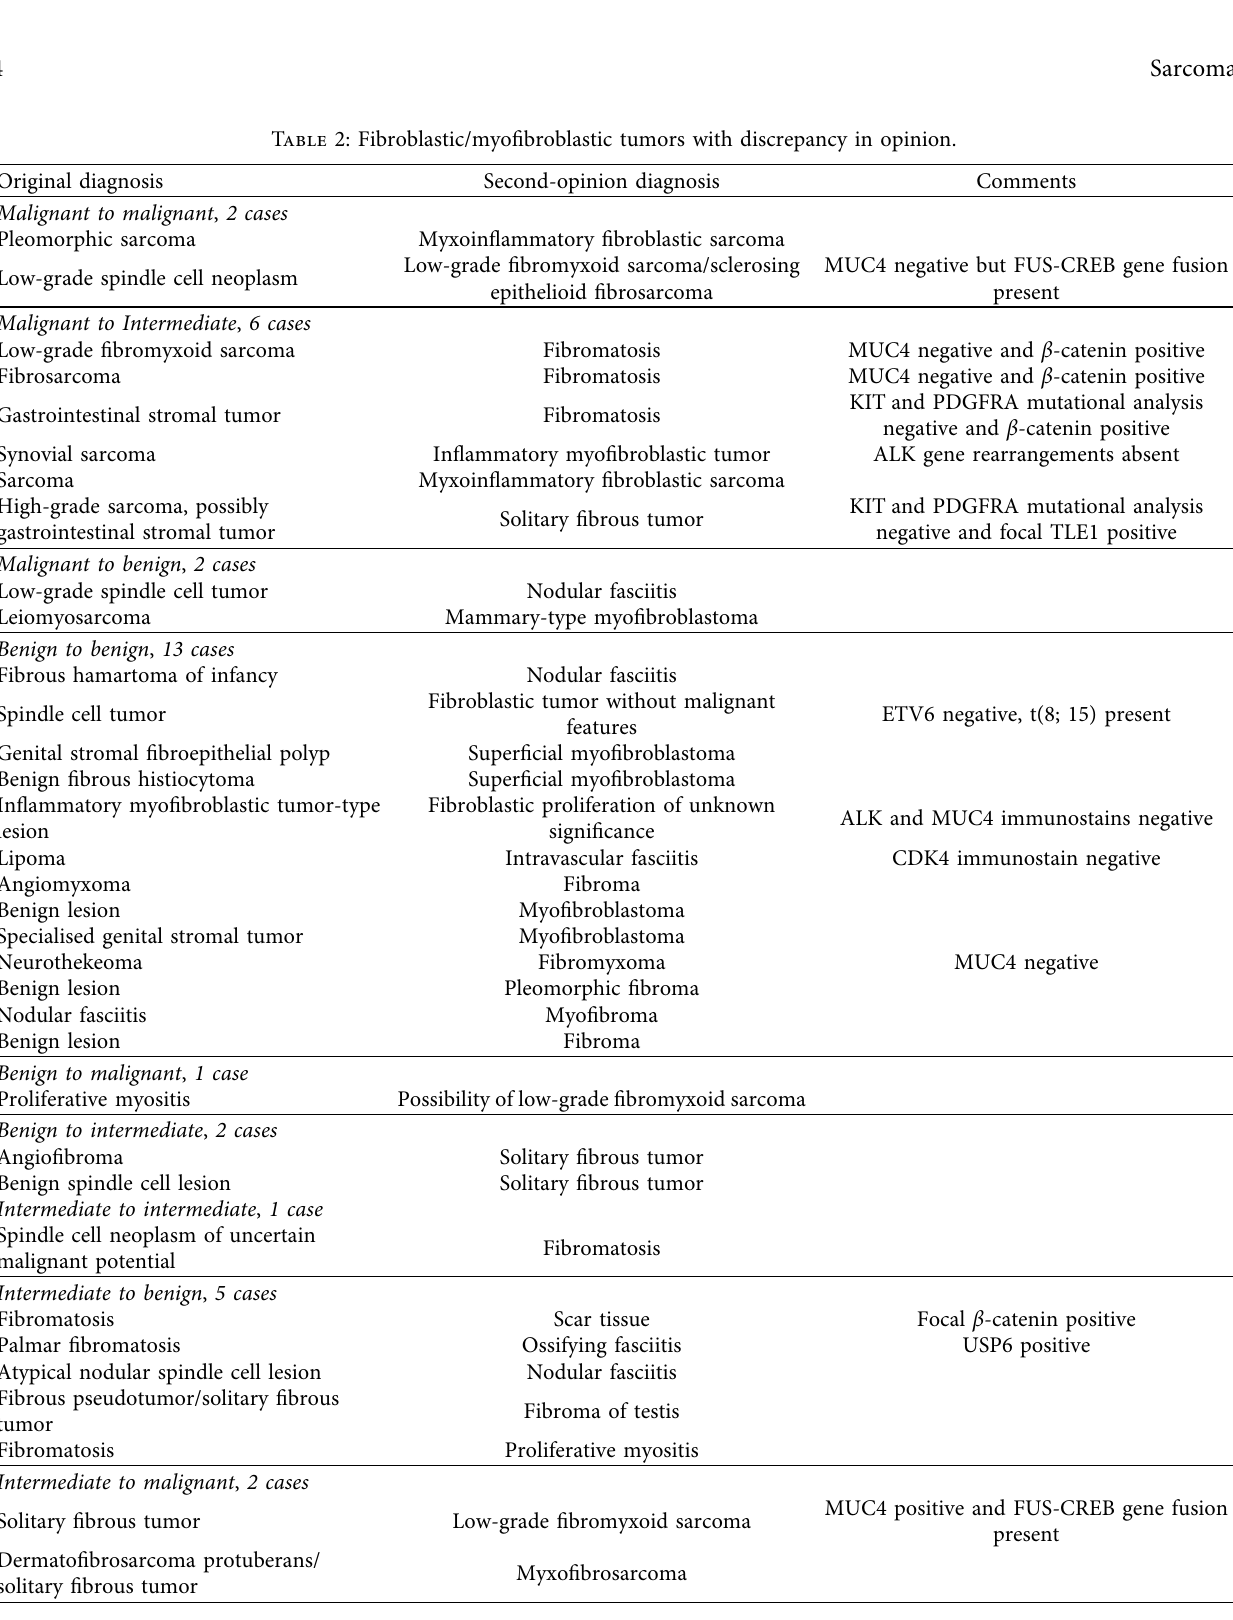
Table 2: Fibroblastic/myofibroblastic tumors with discrepancy in